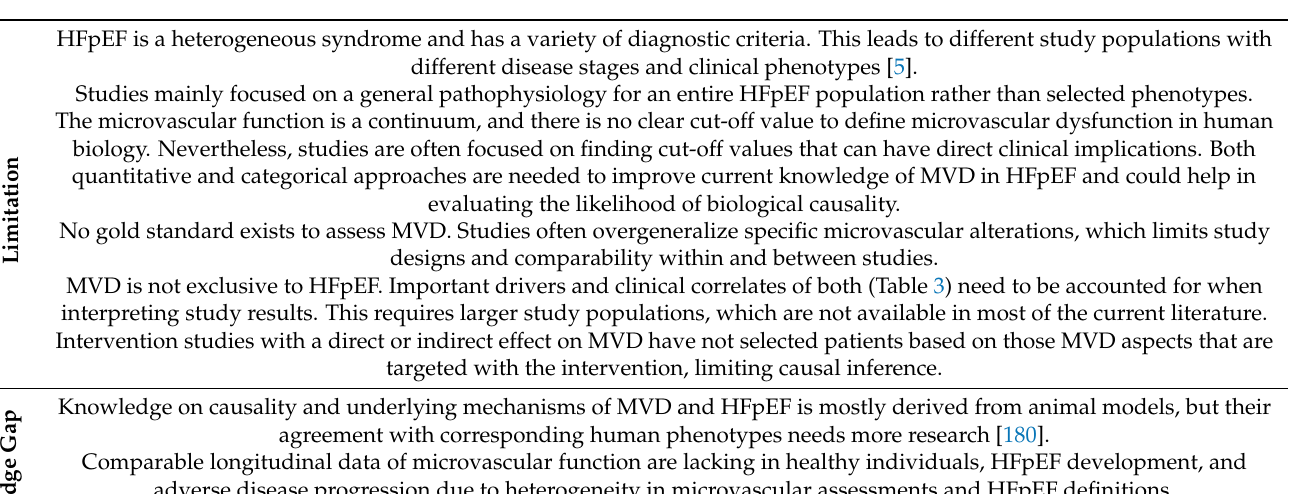
Table 4. Major limitations and knowledge gaps for MVD in